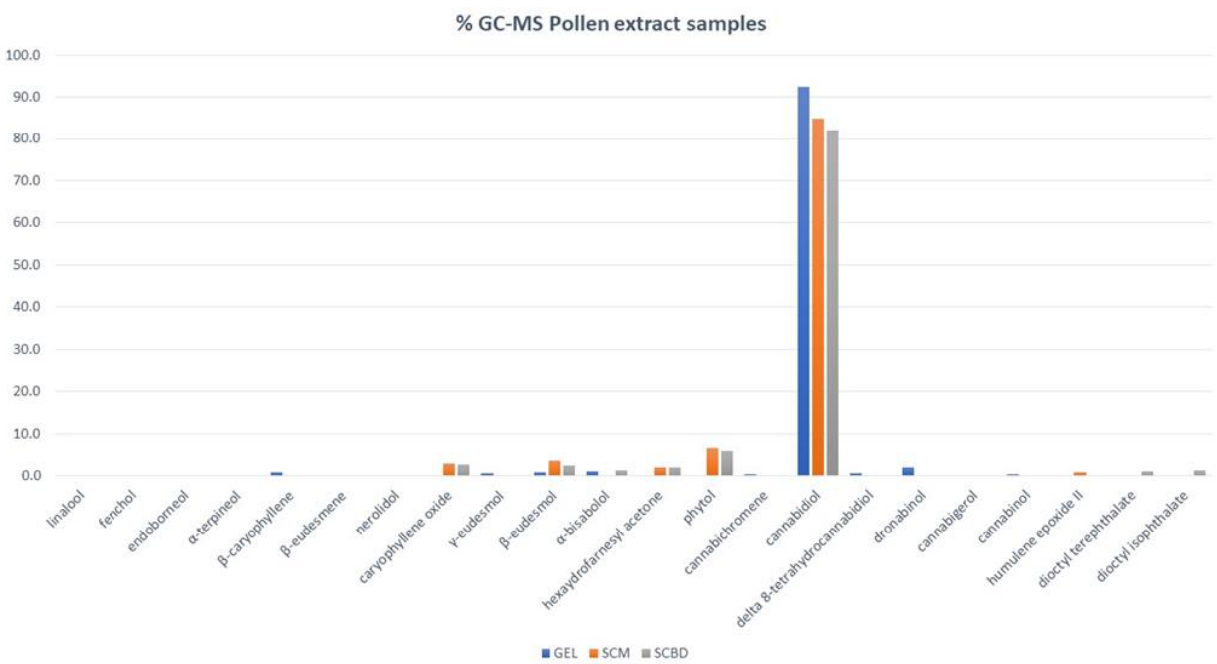
Figure 2. Chemical volatile percentage composition of GEL, SMC, and SCBD of C. sativa pollen extracts. Table 3. Chemical composition (percentage emission for each m / z detected) of C. sativa pollen identified via PTR-ToF-MS. Data are expressed as % on the